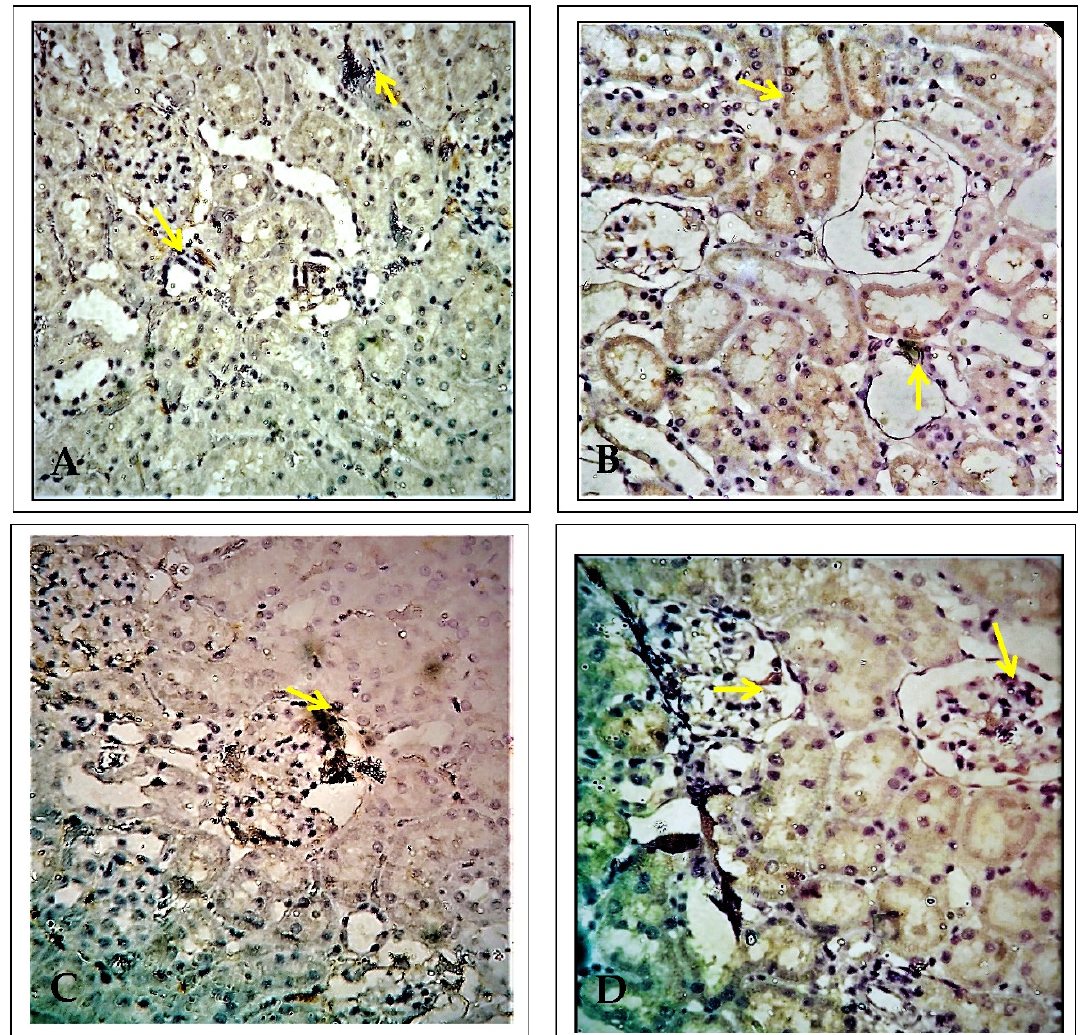
Figure 6. Delta-aminolevulinate dehydratase immunohistochemistry of the kidney (200× magnification). ( A ) Control, ( B ) lead acetate (PbA; 30 mg/kg body weight (b.w.)), ( C ) N -acetylcysteine (NAC; 200 mg/kg b.w.) + PbA (30 mg/kg b.w.), and ( D ) ethanolic extract of Celastrus paniculatus seeds (EECP; 800 mg/kg b.w.) + PbA (30 mg/kg b.w.). The arrows indicate immunopositive regions.